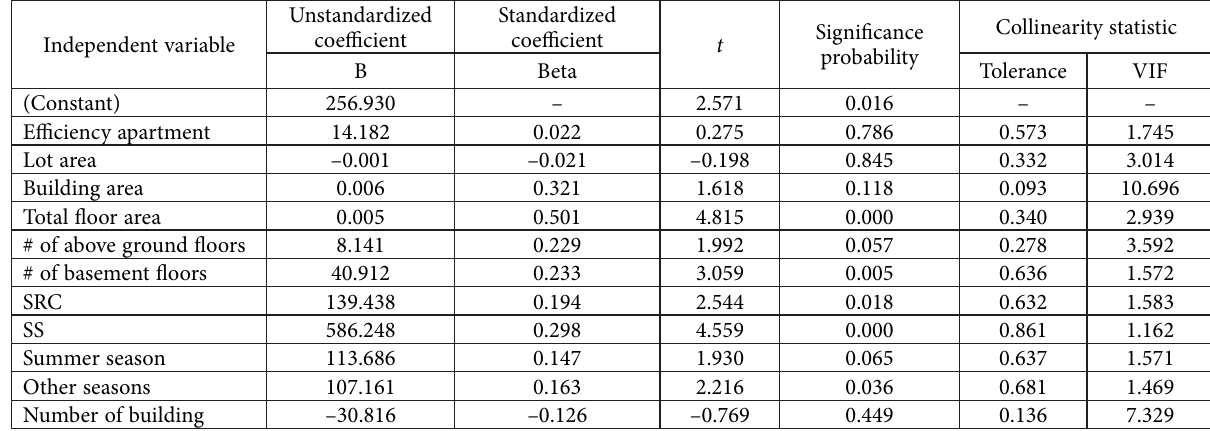
Table 9. Multiple linear regression analysis using the input method – coefficient